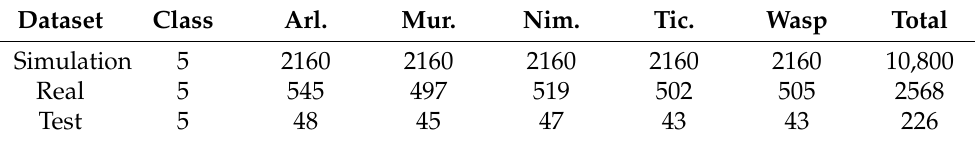
Table 1. Dataset information.